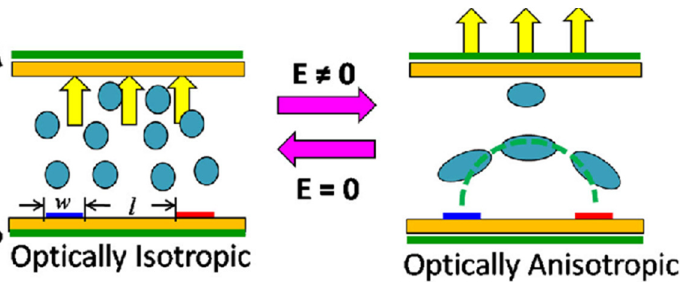
Figure 1. Schematic representation of the Kerr effect for blue-phase liquid crystals [50]. Emerging blue-phase LCDs from L Rao, Spienewsroom; published by Society of Photo-optical Instrumentation Engineers.